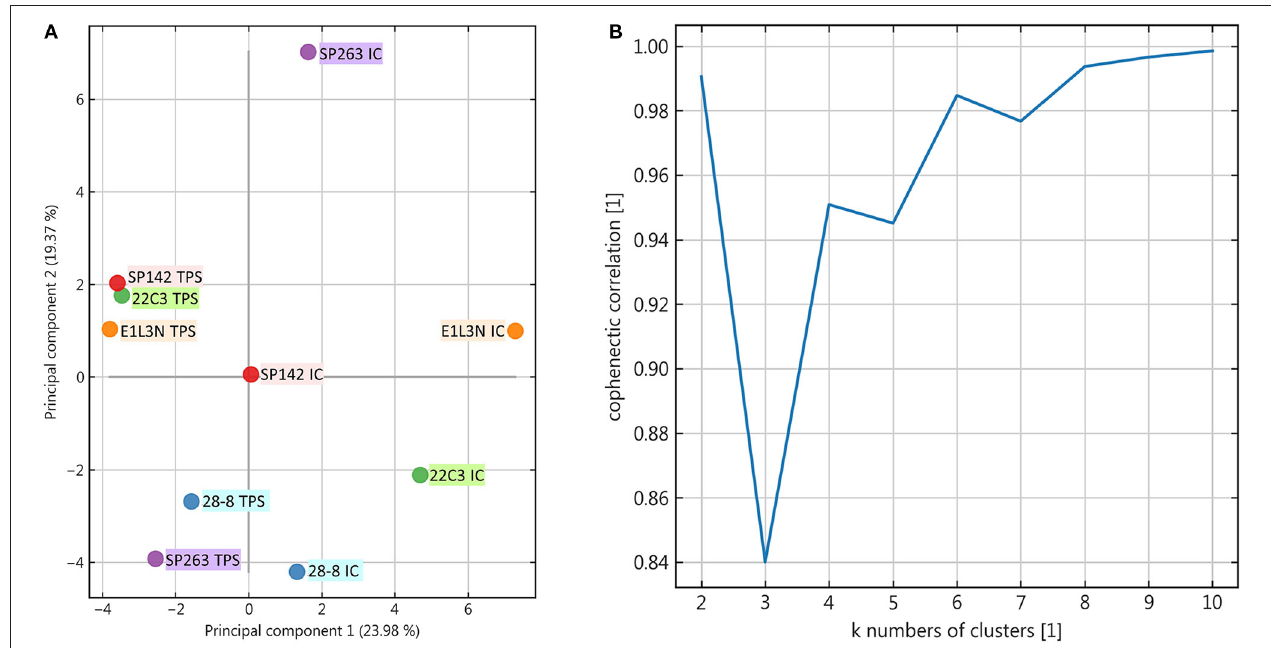
FIGURE 4 | Principal component analysis and rank estimate for non-negative matrix factorization (NMF) consensus clustering. (A) : Principal components were calculated for the dataset and the individual clones visualized two-dimensionally according to their relative correlation with the two main components; (B) : In NMF the cophenetic correlation was calculated to find the number of clusters that reduced dimensionality